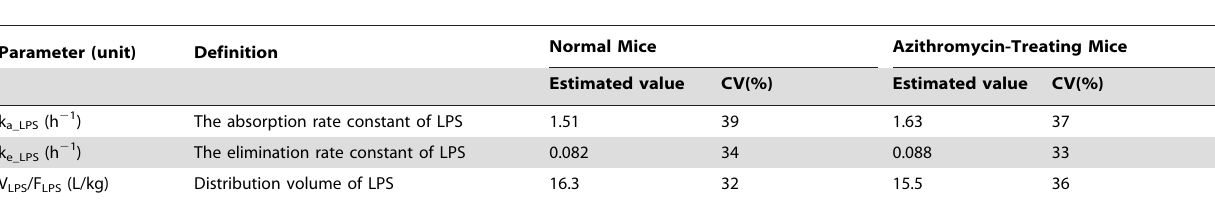
Table 2. The Pharmacokinetic Parameters of LPS in Normal Mice and Azithromycin-Treating Mice.